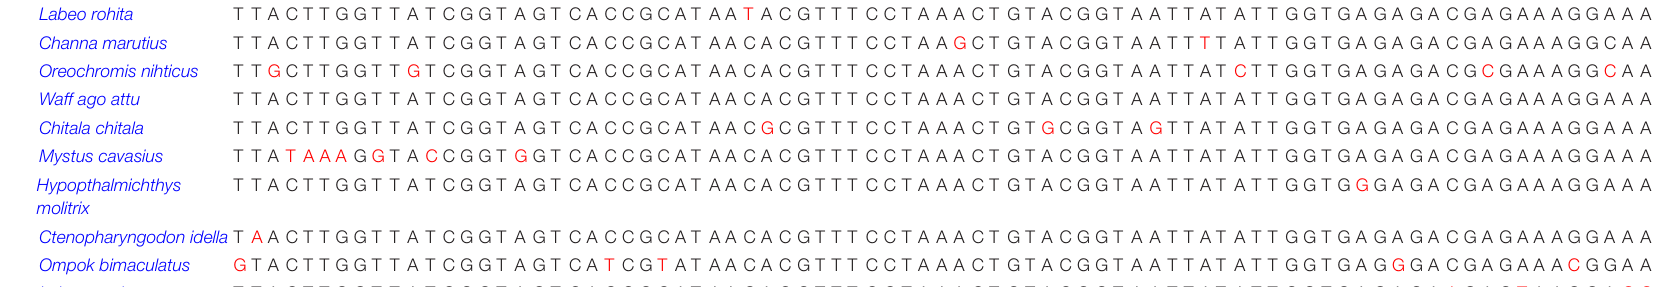
TABLE 5 | Identification of freshwater fish species based on single nucleotide polymorphism data analysis. Labeo rohita